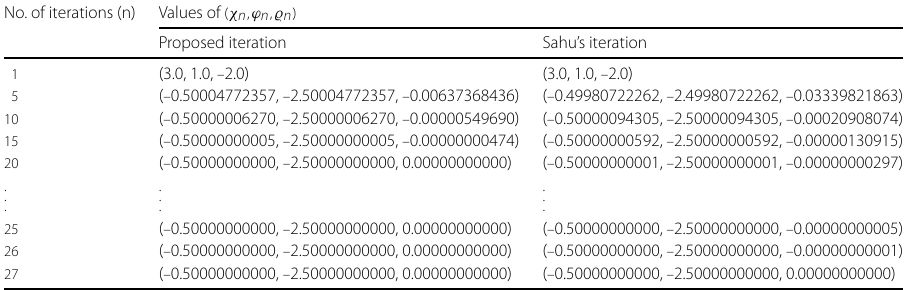
Table 3 Iterative values with starting point